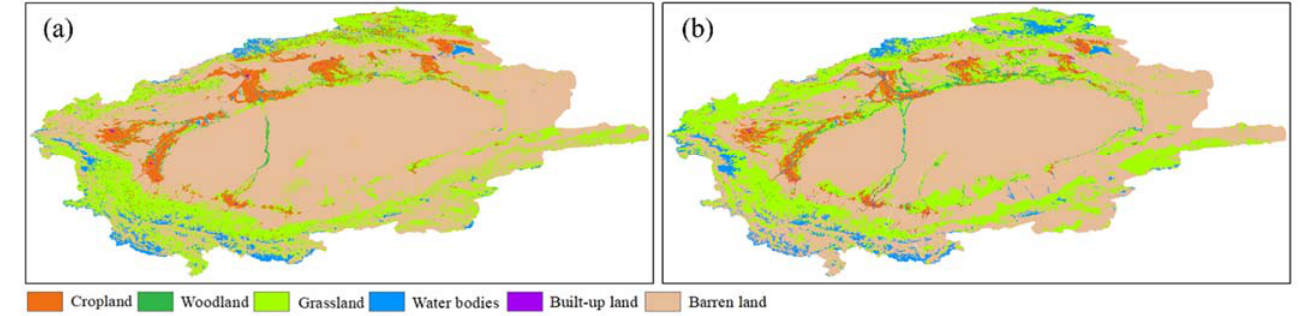
Table 3. Dynamic attitude/intensity analysis of land use in Tarim River Basin during 2020–2030 (km 2 ).